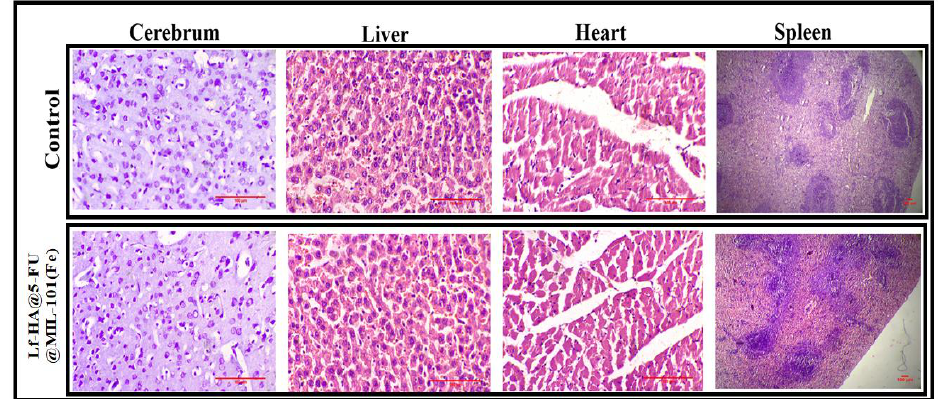
Figure 15. Histopathological images of major organs after treatment with SM-MIL for 14 days. Table 2. Average body weight of rats treated with different doses of SM-MIL. Dose of SM-MIL (mg/kg)